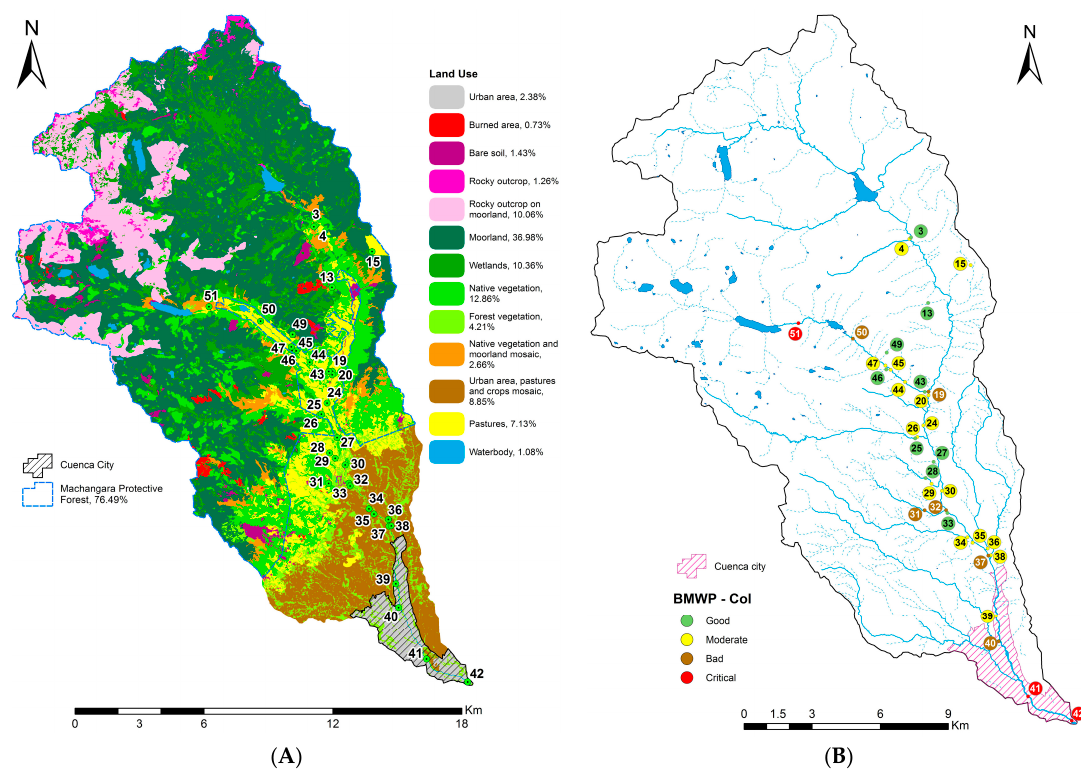
Figure 2. Sampled site locations with ( A ) land use; ( B ) Biological Monitoring Working Party score adapted to Colombia (BMWP-Col) qualification. Table 1 . Summary of the physical, chemical and microbiological data collected in the Machangara Basin in Ecuador based on 33 samples in 2012.